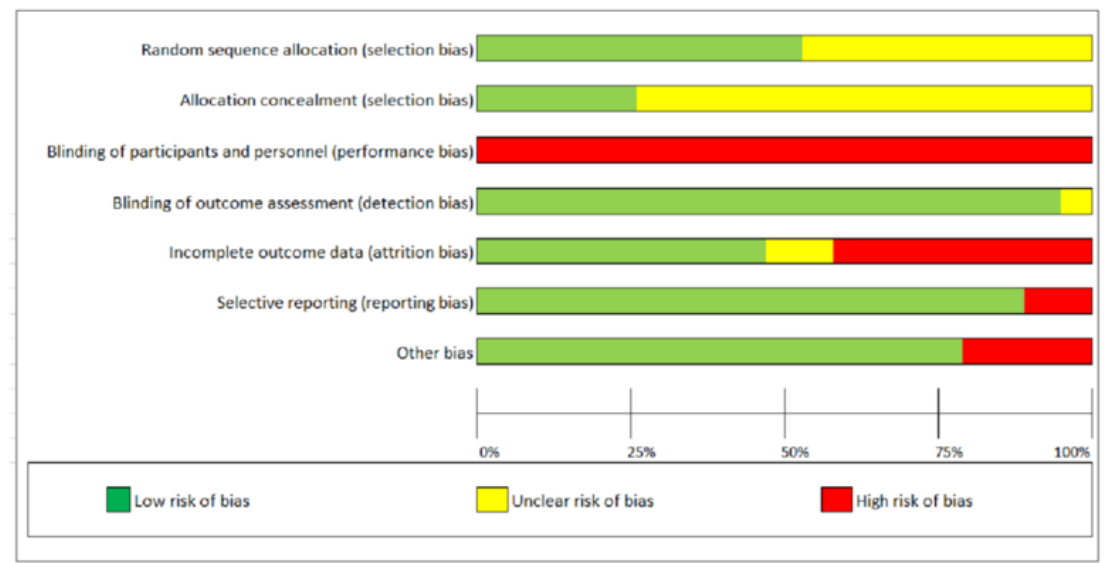
Figure 3. Summary of the risk of bias for all included studies in this meta-analytic